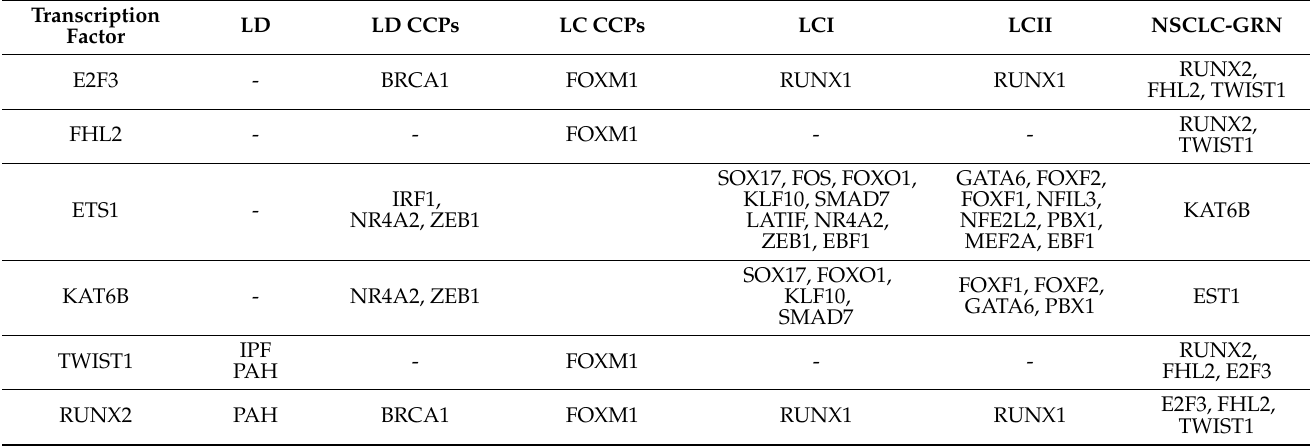
Figure 2. Coregulatory networks of transcription factors related to the establishment and progression of NSCLC lung cancer. Table 1. Main results of our previous bioinformatics analysis [12,31] related to the six regulators in the gene regulatory network of non-small-cell lung cancer (NSCLC-GRN). First, other lung diseases (LD) (IPF (idiopathic pulmonary fibrosis); PAH (pulmonary arterial hypertension)) in which the NSCLC- GRN regulators are deregulated. Then, the transcription factors that regulate common connectivity patterns (CCPs) and the networks of unique lung cancer genes that are not deregulated in other lung diseases (LCI) or other types of cancer (LCII) and the transcription factors in the NSCLC-GRN that can act as coregulators of every NSCLC-GRN